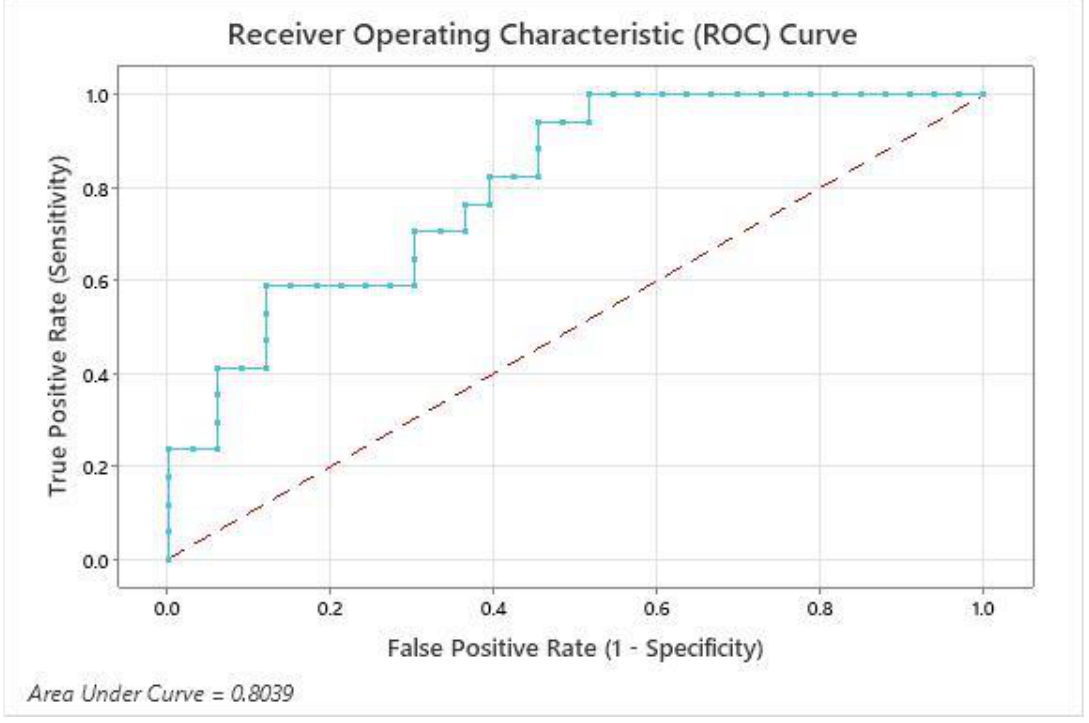
Figure 3. ROC graph for the estimation of the prognostic role of serum IL-6 in LSDV-infected cattle. Infected cattle ( n = 50) were categorized based on clinical recovery status at 17 days after the onset of disease (recovered group, n = 33; unrecovered group, n = 17).